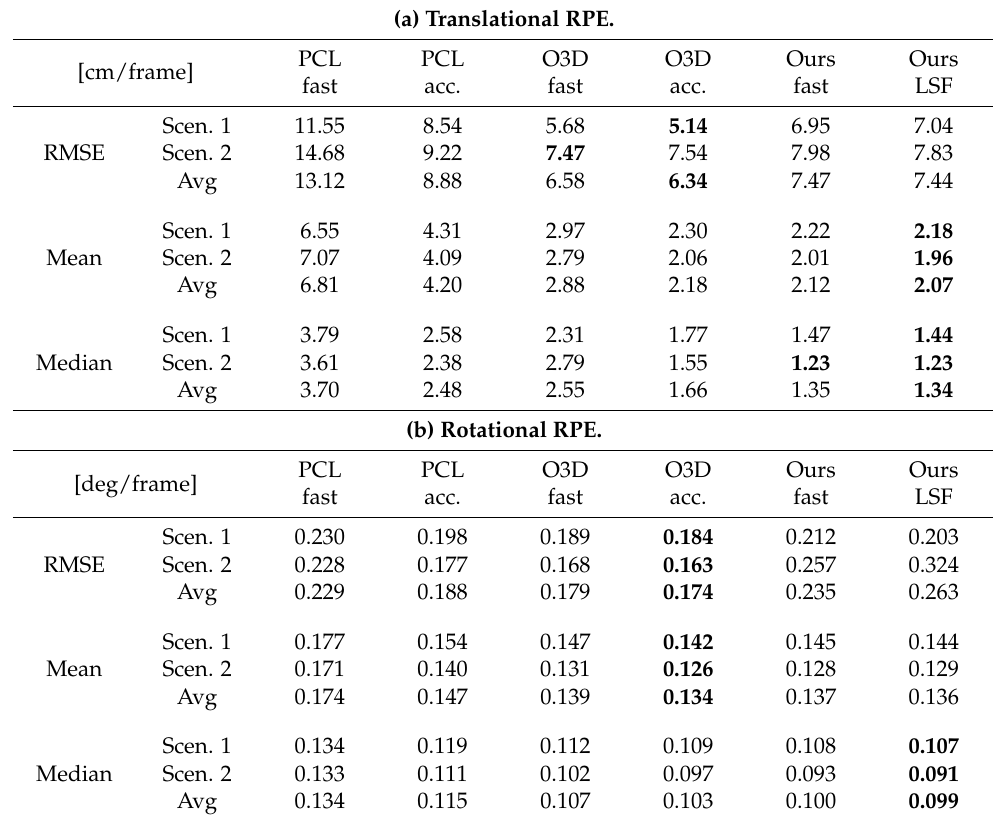
Table 3. RPE comparison between the different